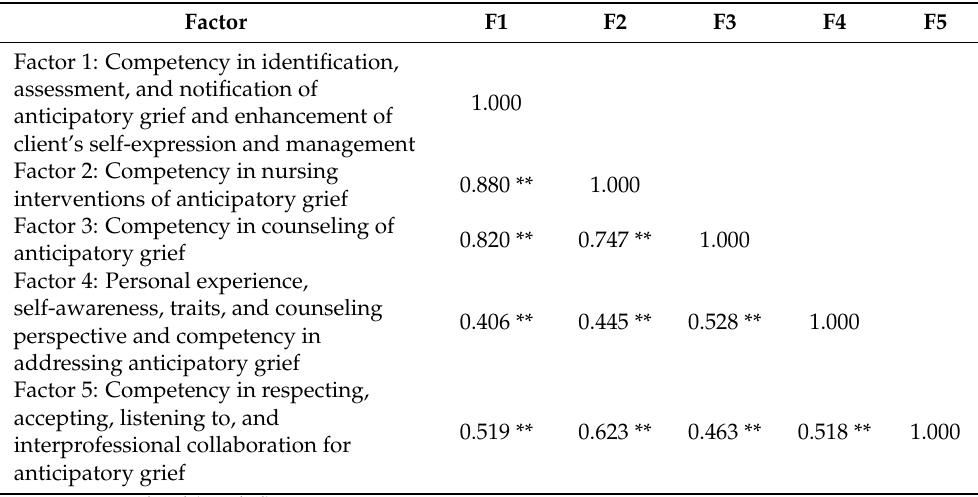
Table 2. Pearson correlation coefficients between the five factors of the Anticipatory Grief Counseling Competency Scale (n = 251).